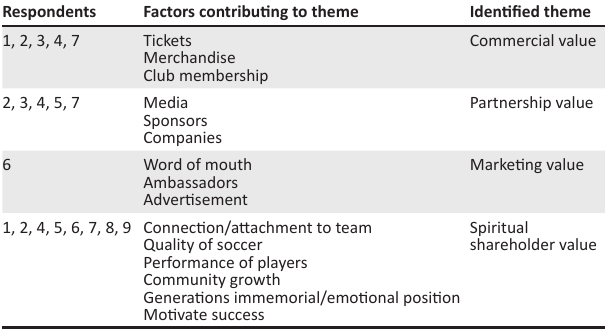
TABLE 2: Responses of respondents towards the value of